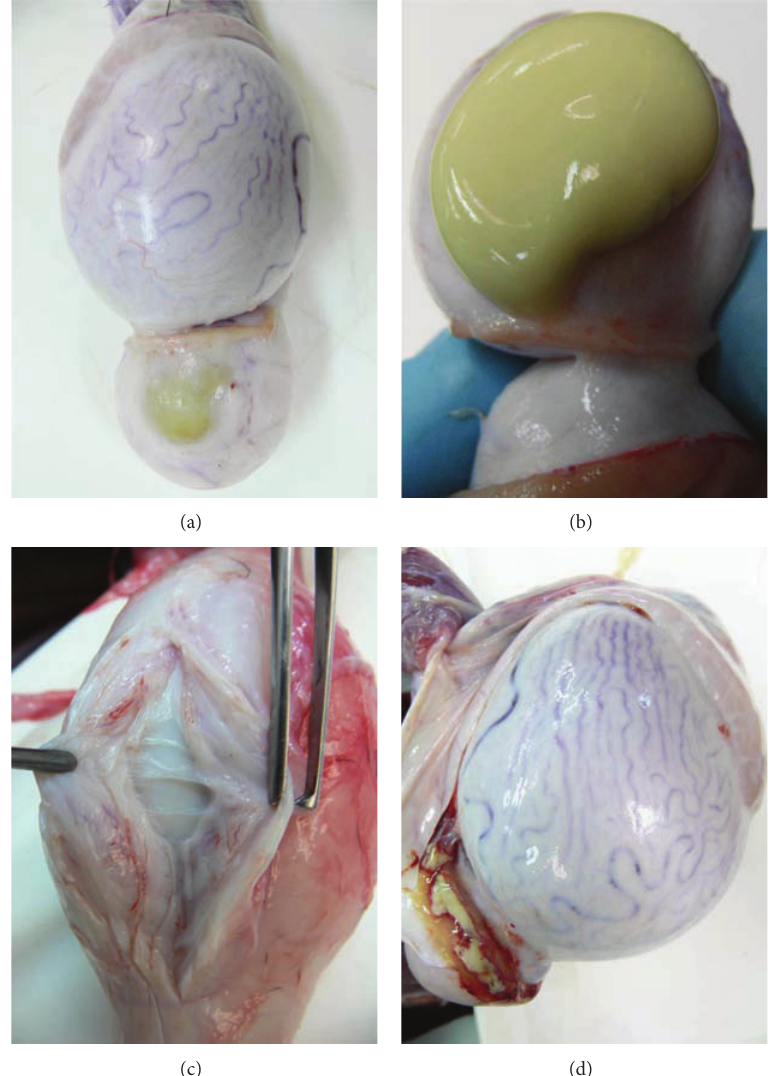
Figure 5: Gross findings in rams experimentally infected with Actinobacillus seminis. ((a) and (b)) Epididymal abscess. (a) Tail of the left epididymis is increased with focal yellowish area and (b) filled with yellowish viscous fluid (purulent exudate). (c) Testicular atrophy is associated with diffuse fibrosis of the tunica vaginalis. Left testis is decreased in volume and tunica vaginalis is thickened and firmly adhered to the testis. (d) Severe purulent epididymitis. Tail of the left epididymis is surrounded by purulent exudate and